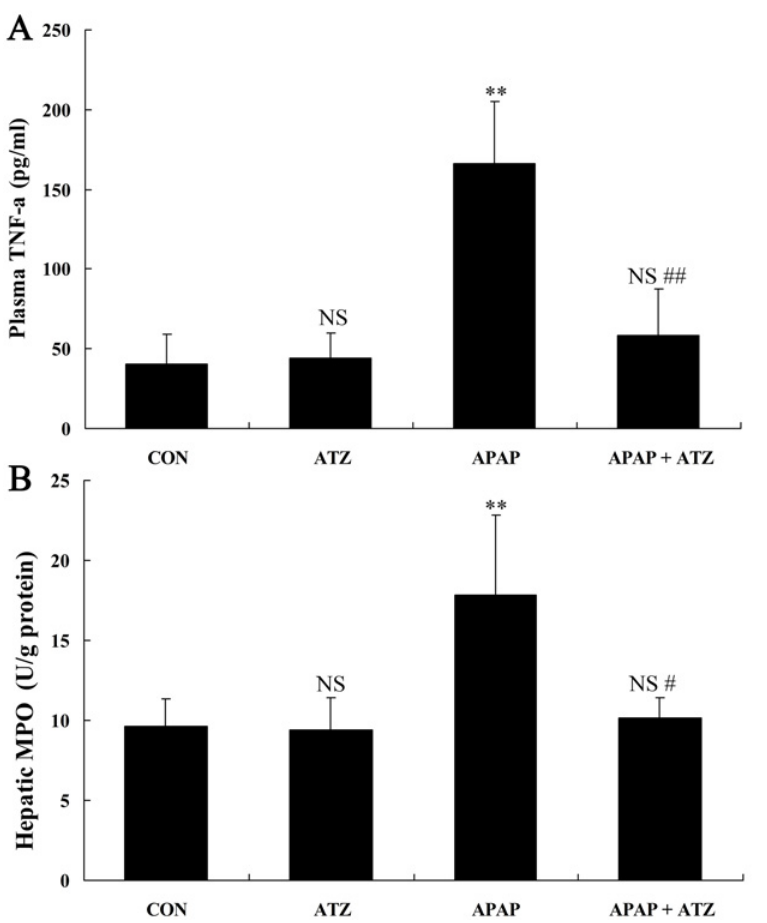
Fig 5. Pretreatment with APAP suppressed the levels of plasma TNF- α and hepatic MPO in APAP exposed mice. Plasma TNF- α levels (A) and hepatic MPO activities (B) were determined at 8 h after APAP exposure. Data were expressed as mean ± SD, n = 8. NS P > 0.05, ** P < 0.01, as compared with the CON group; # P < 0.05, ## P < 0.01, as compared with APAP